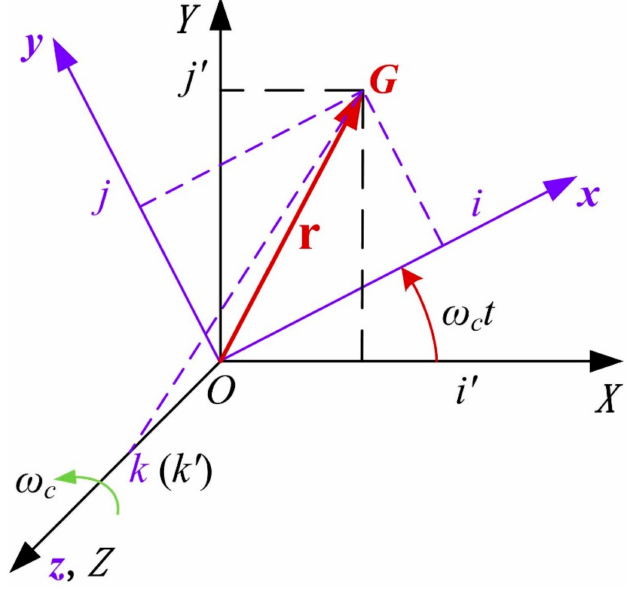
Figure 3. Coordinate